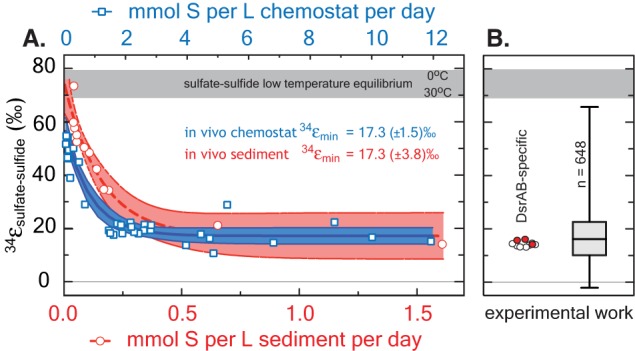
A comparison between modern marine (environmental) and laboratory (experimental) S isotope fractionations, as a function of sulfate reduction rate. These data are further referenced to a statistical distribution of published experimental fractionation data. (A) Fractionation as a function of volumetric sulfate reduction rate from axenic continuous culture experiments (blue squares and regression; Leavitt et al., 2013) and modern marine sediments (red circles and regression; Goldhaber and Kaplan, 1975). Solid lines are mean values with shaded regions representing the 95% confidence interval around a non-linear regression. While the upper fractionation limits are offset, perhaps due to differences in biomass per volume of sediment vs. volume of chemostat, the limits approached at high reduction rates are statistically indistinguishable at 17.3‰. (B) The fractionation associated with DsrAB experiments, color-coded as in Figure 3 and on the same isotope scale. Also included is a box-whisker treatment of all measured 34ε (n = 648) sulfate and sulfite reduction experiments compiled in Figure 4. Here, the median value is 16.1‰, also statistically indistinguishable from chemostat and modern marine sediments limits at elevated rates of sulfate reduction. Included for reference is the theoretical sulfate-sulfide equilibrium fractionation (gray bar) for 0–30°C (Farquhar et al., 2003).